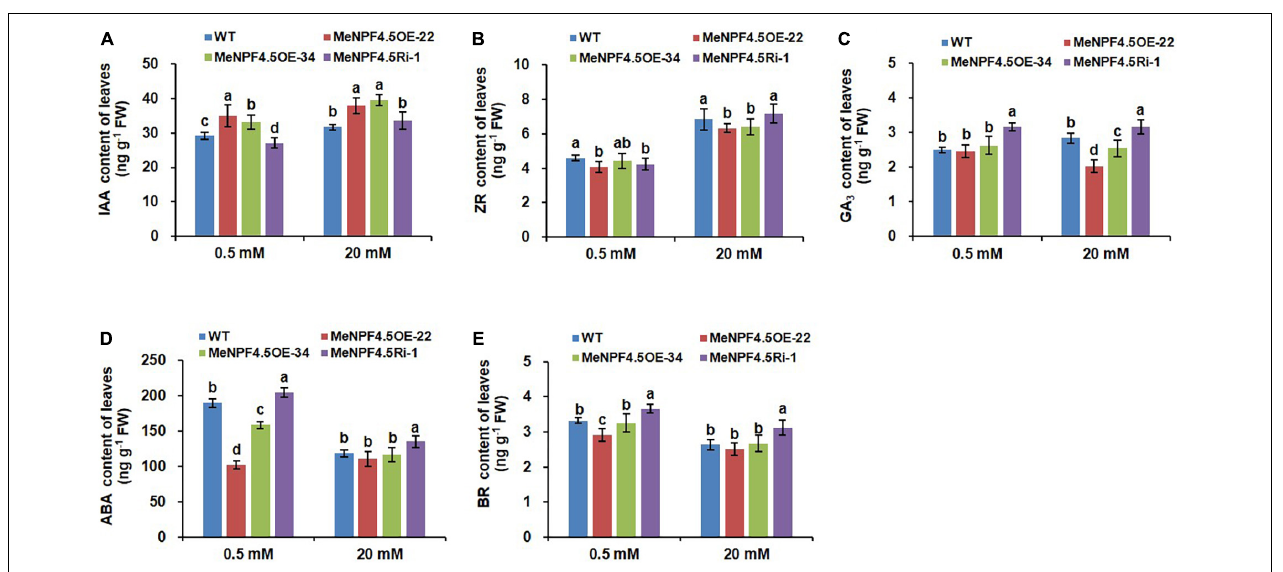
FIGURE 7 | Endogenous hormone levels in roots of WT and MeNPF4.5 transgenic cassava plants cultivated in tissue culture for 25 days. (A–E) contents of indoleacetic acid (IAA) (A) , zeatin-riboside (ZR) (B) , gibberellic acid (GA 3 ) (C) , abscisic acid (ABA) (D) , and brassinolide (BR) (E) . Values are the means of three biological replicates ± SE. Lowercase letters above the bars (a–d) represent significant differences between treatments as determined by Student’s t -test ( P < 0.05).